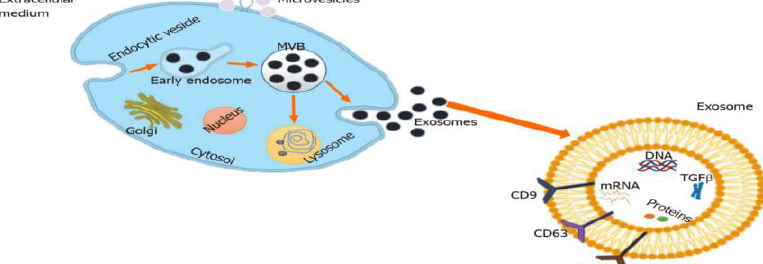
Figure 2. Biogenesis of exosomes. Exosome biogenesis begins with early endosomes and subsequently becomes mature en- dosomes known as multivesicular bodies. Early endosomes are formed from the plasma membrane via the endocytic pathway. According to the function, Multivesicular bodies (MVB) can be directed to the plasma membrane and be released into the ex- tracellular space as exosomes. During the formation of exosomes, proteins (tetraspanins, cytosolic proteins, and receptors), nucleic acids (miRNA, mRNA, and DNA), and lipids (sphingomyelin and cholesterol) will accumulate in exosomes.